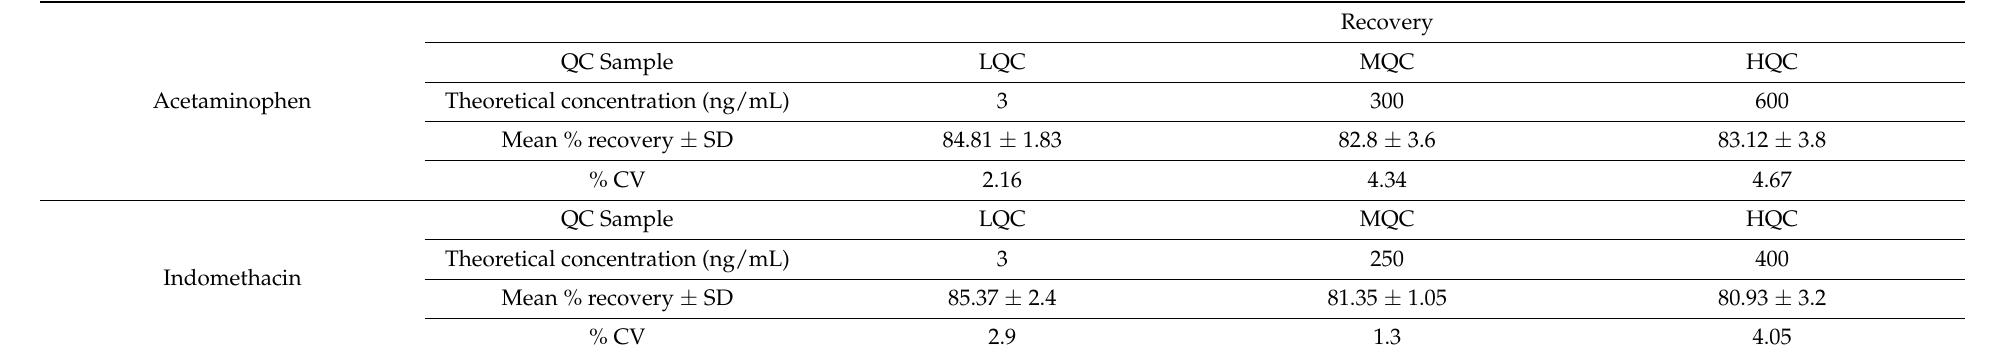
Table 2. Determination ( n = 6) of extraction recovery of analytes present in